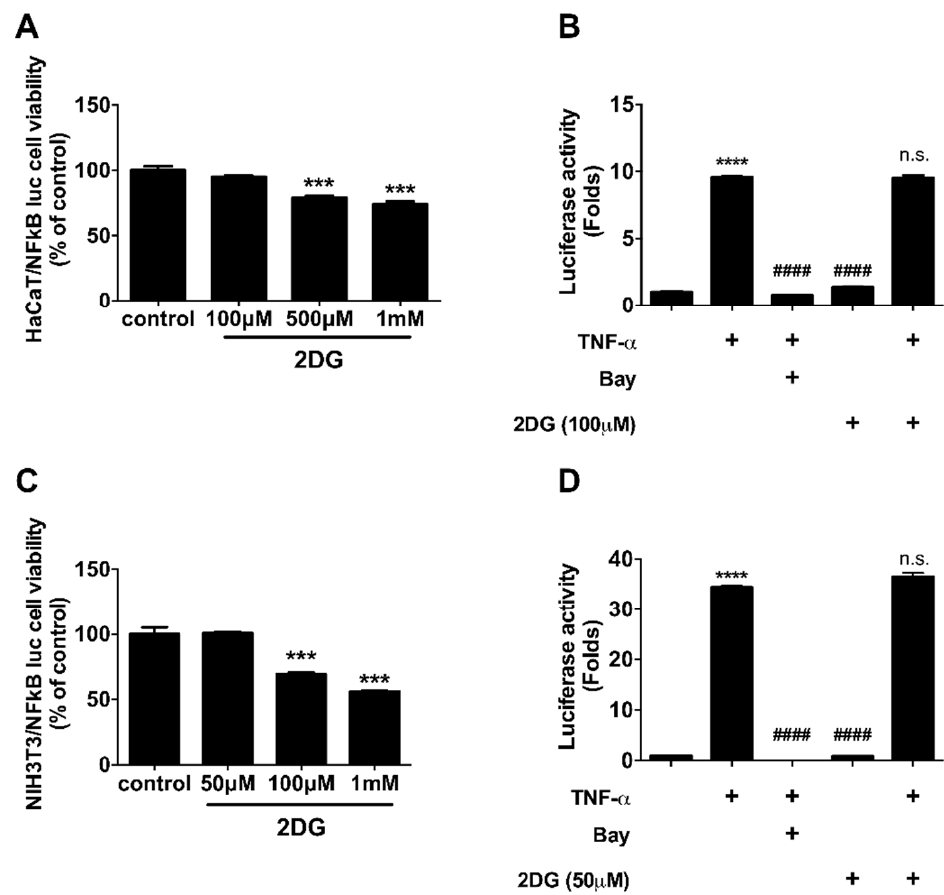
Figure 4. 2DG is not able to modulate NF κ B activity in skin cells. ( A ) Cellular viability of HaCaT cells was measured after 8 h of indicated 2DG treatment. ( B ) Luciferase activity was measured in HaCaT cells after 8 h of 100 µ M of 2DG in the presence of TNF- α . ( C ) Cellular viability of NIH3T3 cells was measured after 8 h of indicated 2DG treatment. ( D ) Luciferase activity was measured in HaCaT cells after 8 h of 50 µ M of 2DG in the presence of TNF- α . Data are presented as mean ± SEM of changes in values. *** p < 0.005 compared to control, **** p < 0.001, #### p < 0.005 compared to TNF- α and n.s., non-significant compared to TNF- α .